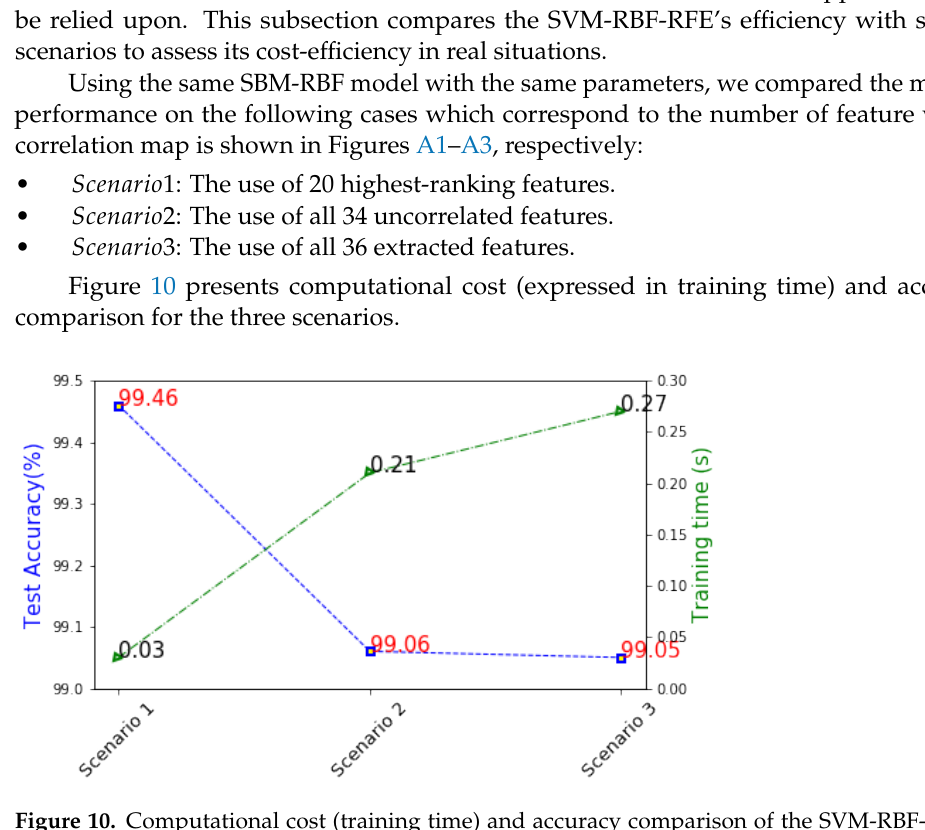
Figure 10. Computational cost (training time) and accuracy comparison of the SVM-RBF-RFE in different feature set